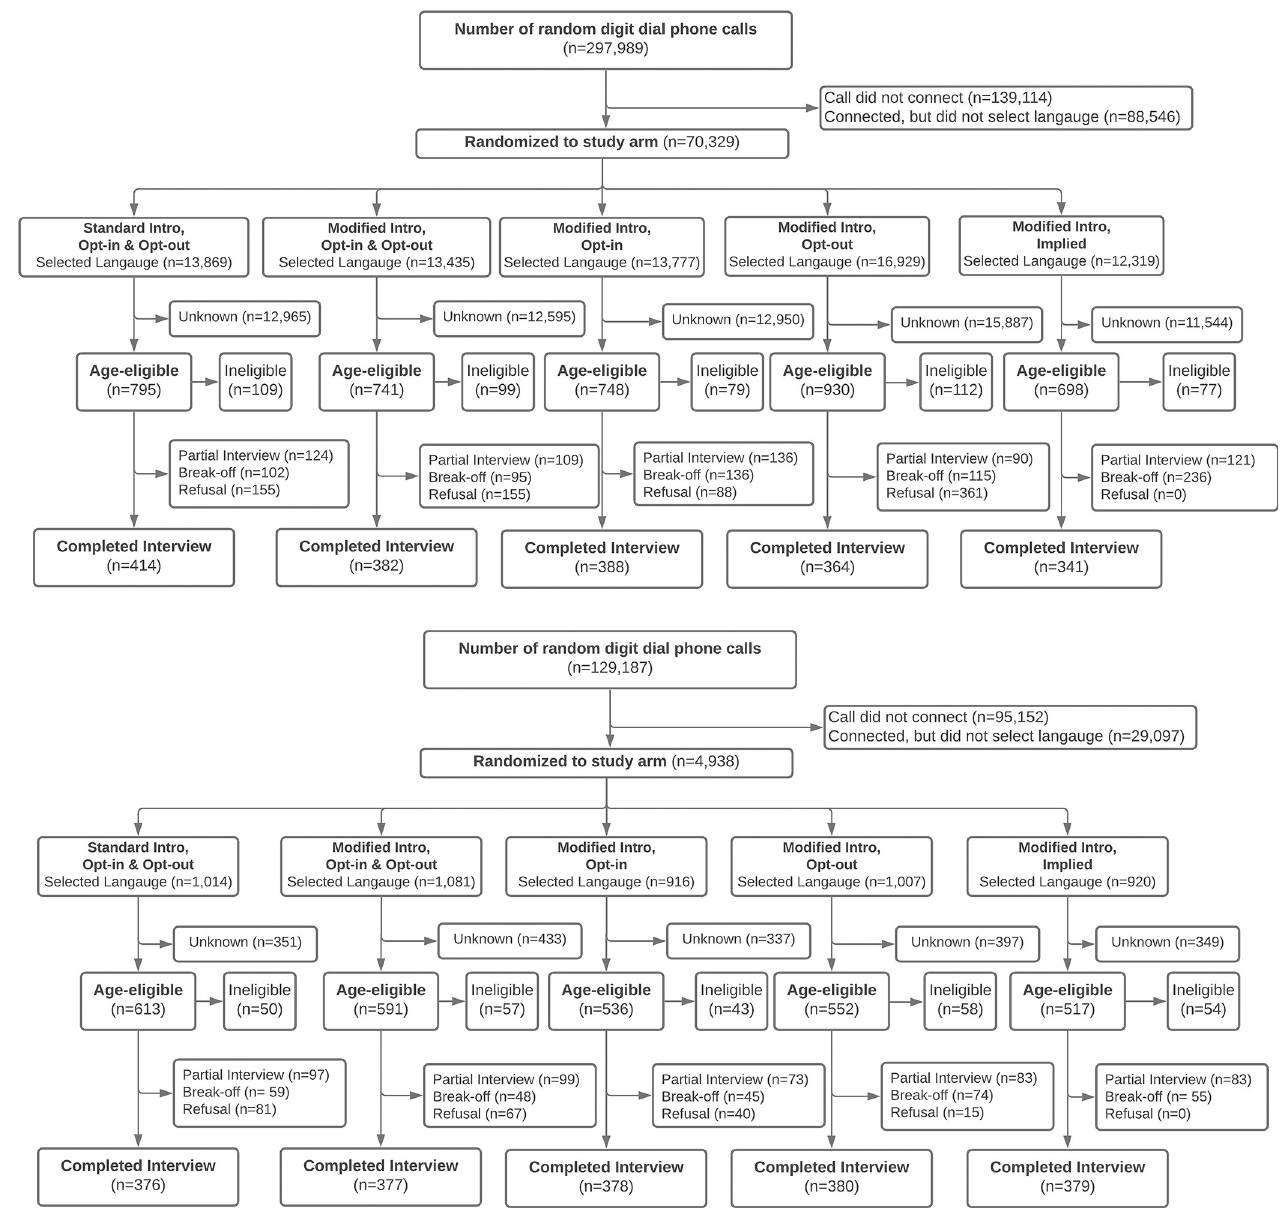
Fig 2. a. CONSORT diagram of interview outcomes among participants in Colombia. b. CONSORT diagram of interview outcomes among participants in Uganda.